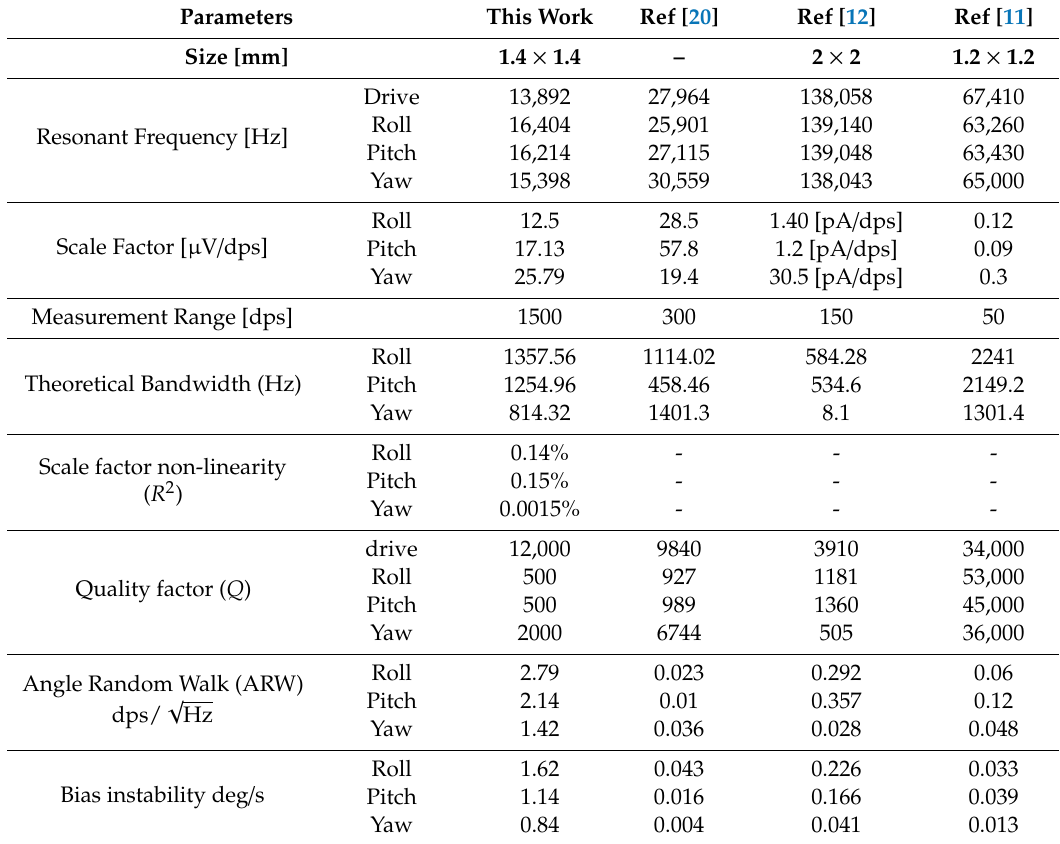
Table 2. Comparison of the designed multi-axis gyroscope with reported fabricated multi-axis